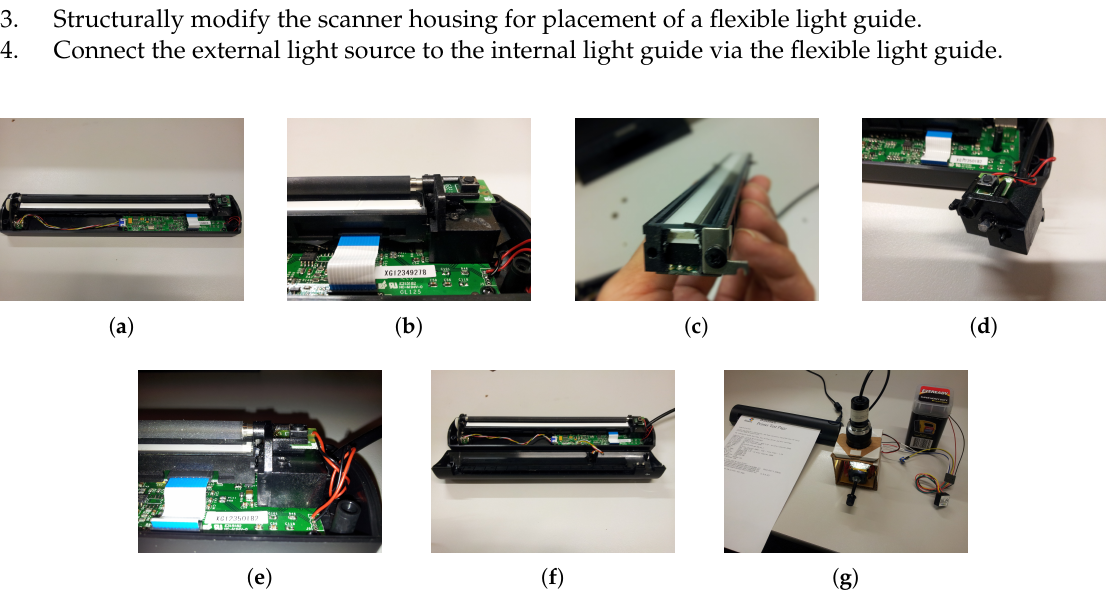
Figure 8. The steps of the scanner modification and its connection to the multispectral light source: ( a ) remove the top cover to gain access; ( b ) release the components from the hinge support; ( c ) disengage RGB LED from the scanner sensor; ( d ) make provision for a flexible light guide; ( e ) re-install the components; ( f ) replace the top cover; and ( g ) connect to the multispectral light